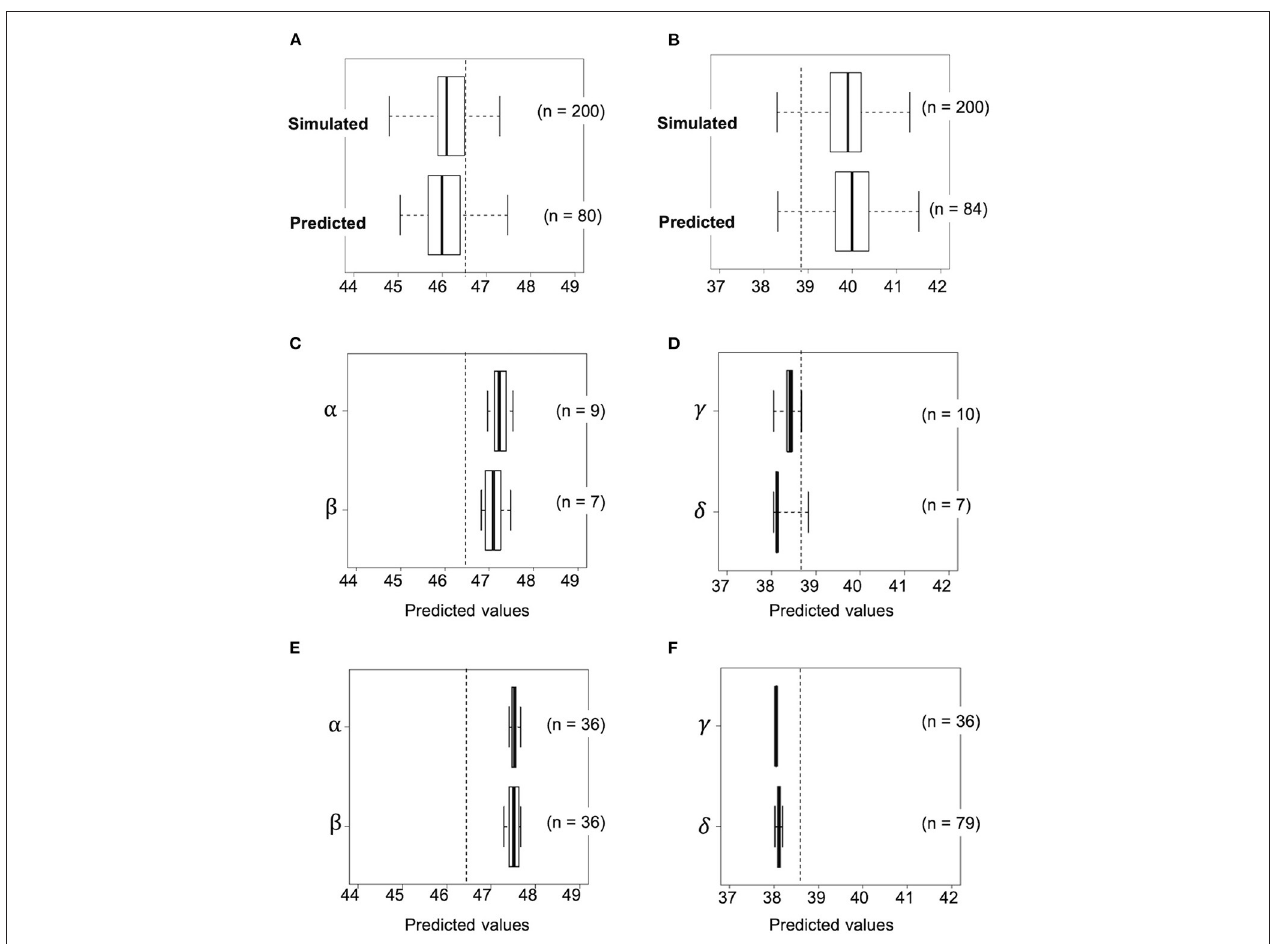
FIGURE 6 | Transition of predicted values based on actual genotypes against selection as the generation progressed. Selection toward high seed protein content by using progeny of a cross combination of RIL048 × RIL176 (A, C, E) and low seed protein content by using that of RIL047 × RIL097 (B, D, F) . (A, B) Upper and lower box plots indicate simulated and predicted values of the F 2 population at the first selection cycle, respectively. (C, D) Boxplots for the predicted values based on the genotype of the second F 1 plants at the second selection cycle. (E, F) Boxplots for the predicted values in the second F 2 population derived from self-pollination of selected second F 1 plants. The whiskers of each boxplot indicate the maximum and minimum values. Dashed lines indicate the highest or lowest estimated value among RILs. Greek letters ( α − δ ) beside the Y -axis indicate identifiers for the cross combination.